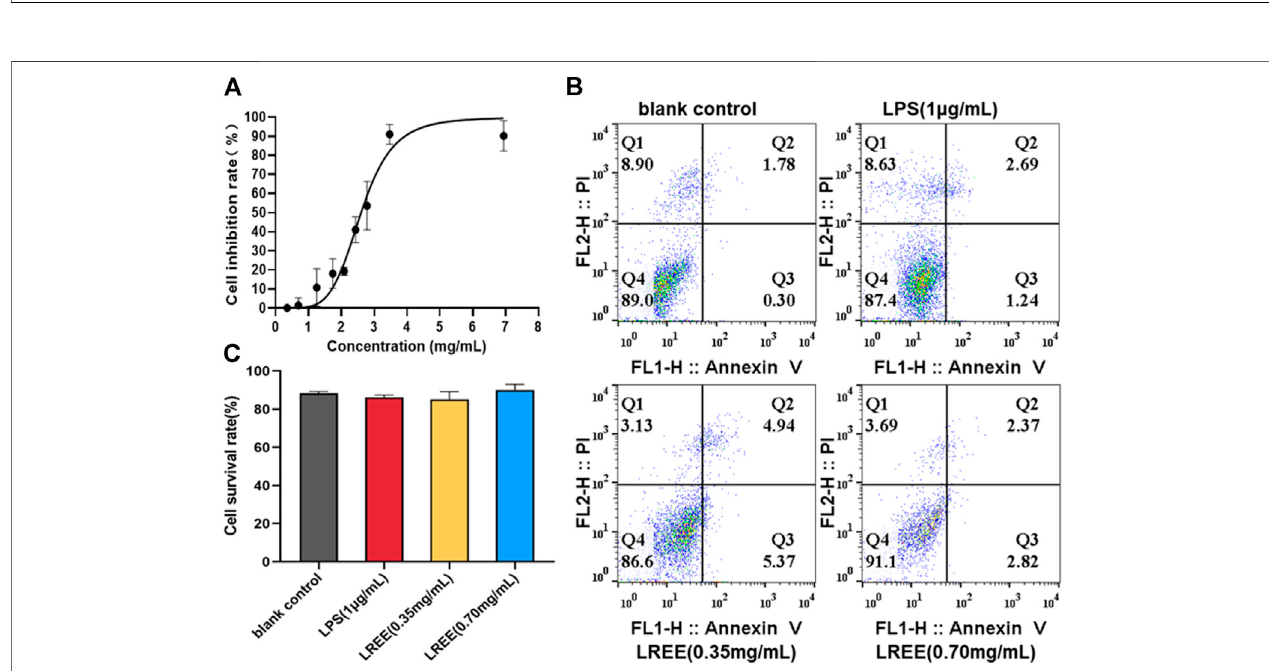
FIGURE 5 | Effects of LREE on the cell viability RAW264.7 macrophages ( n (cid:2) 3). (A) The inhibitory curve of LREE on RAW264.7 cells growth. (B) Apoptosis was detected by Annexin V-APC/PI apoptosis detection kit. (C) Statistical analysis of Q4 area in Figure 5B .